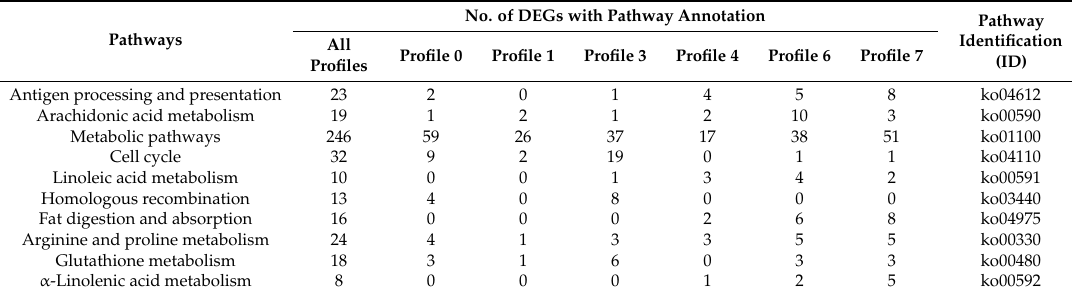
Table 2. Top 10 KEGG pathways with high representation of the DEGs.